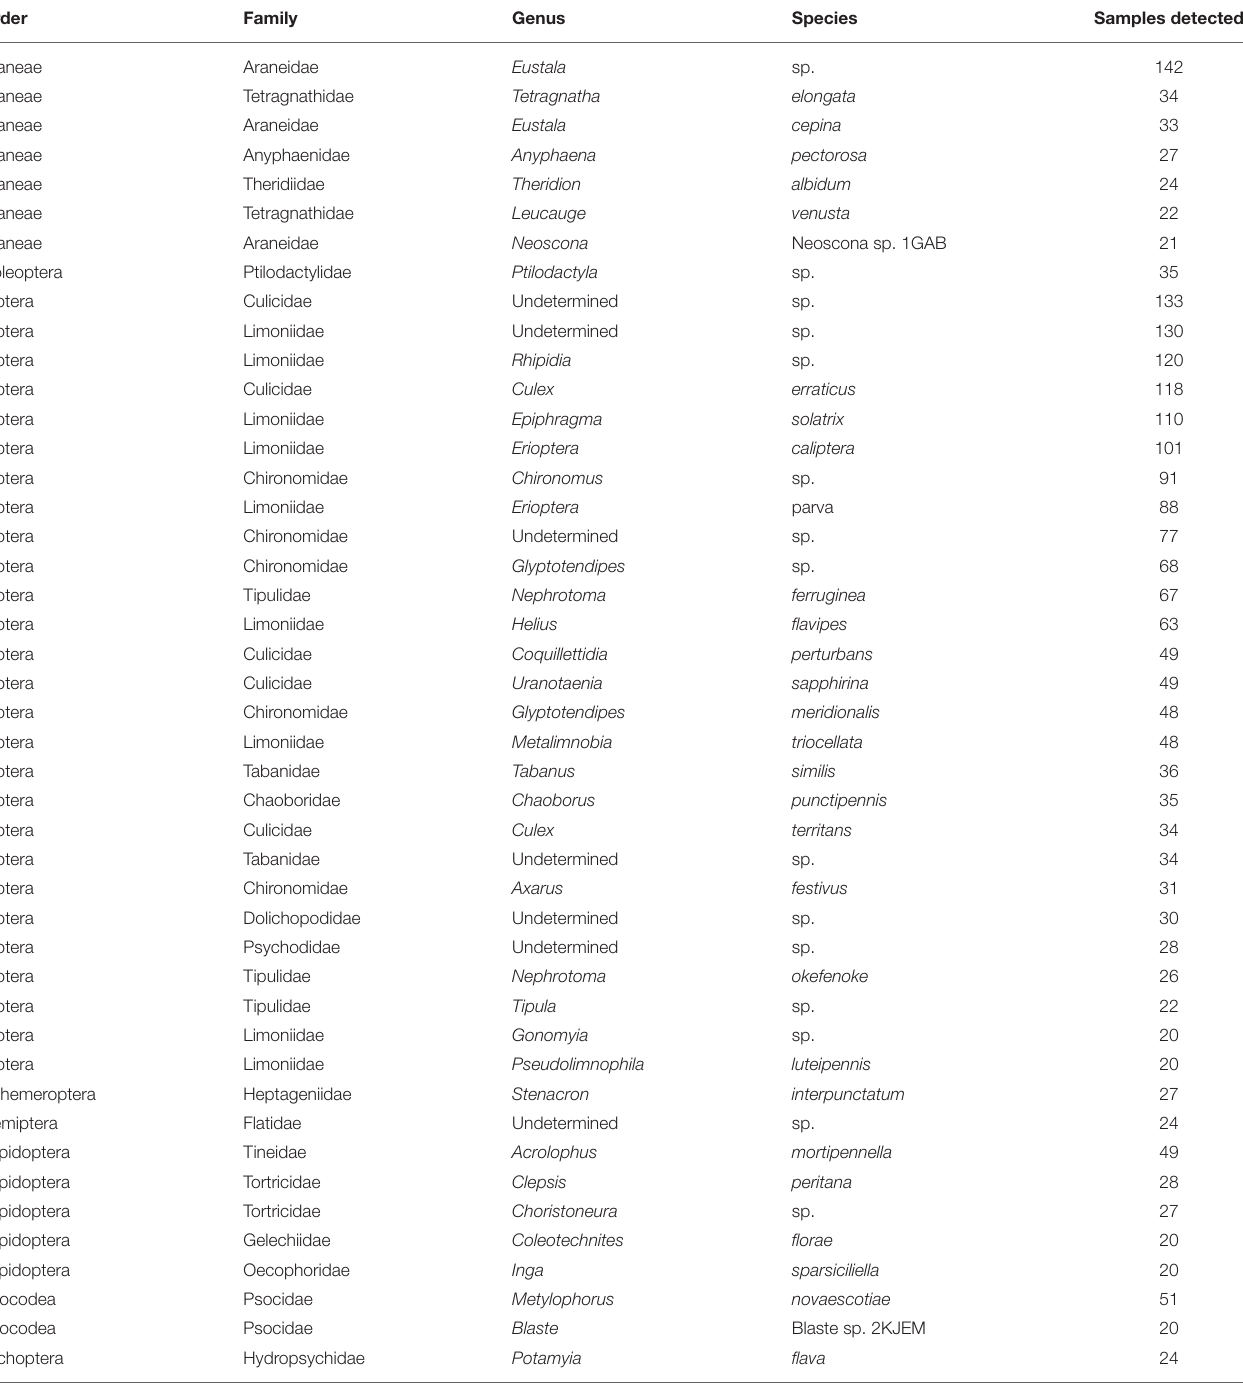
TABLE 2 | Taxonomic information assigned to prevalent sequence clusters (OTUs) detected in Indiana bat